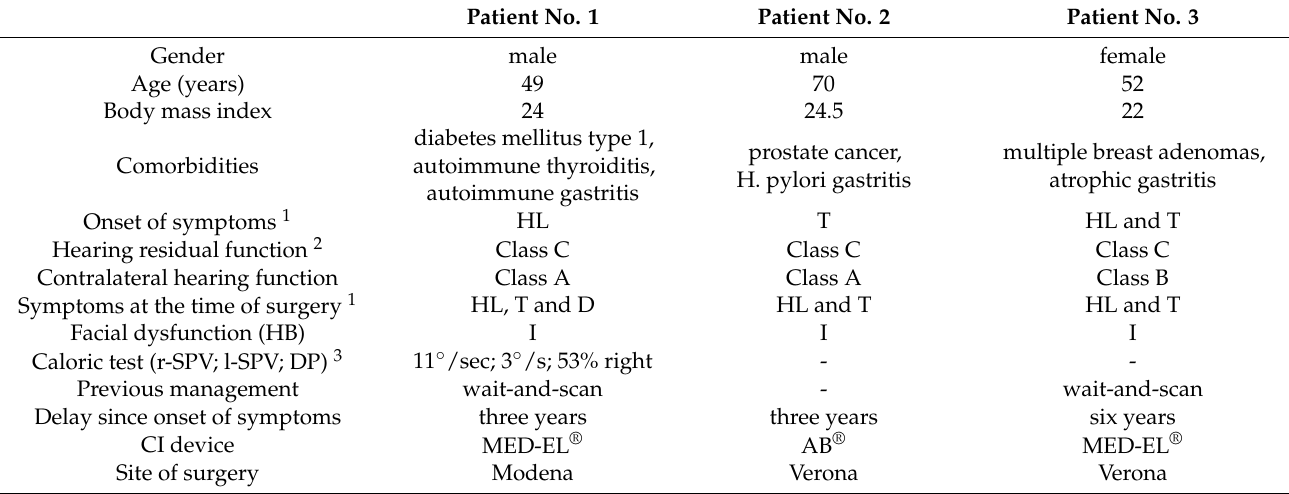
Table 1. Preintervention participants’